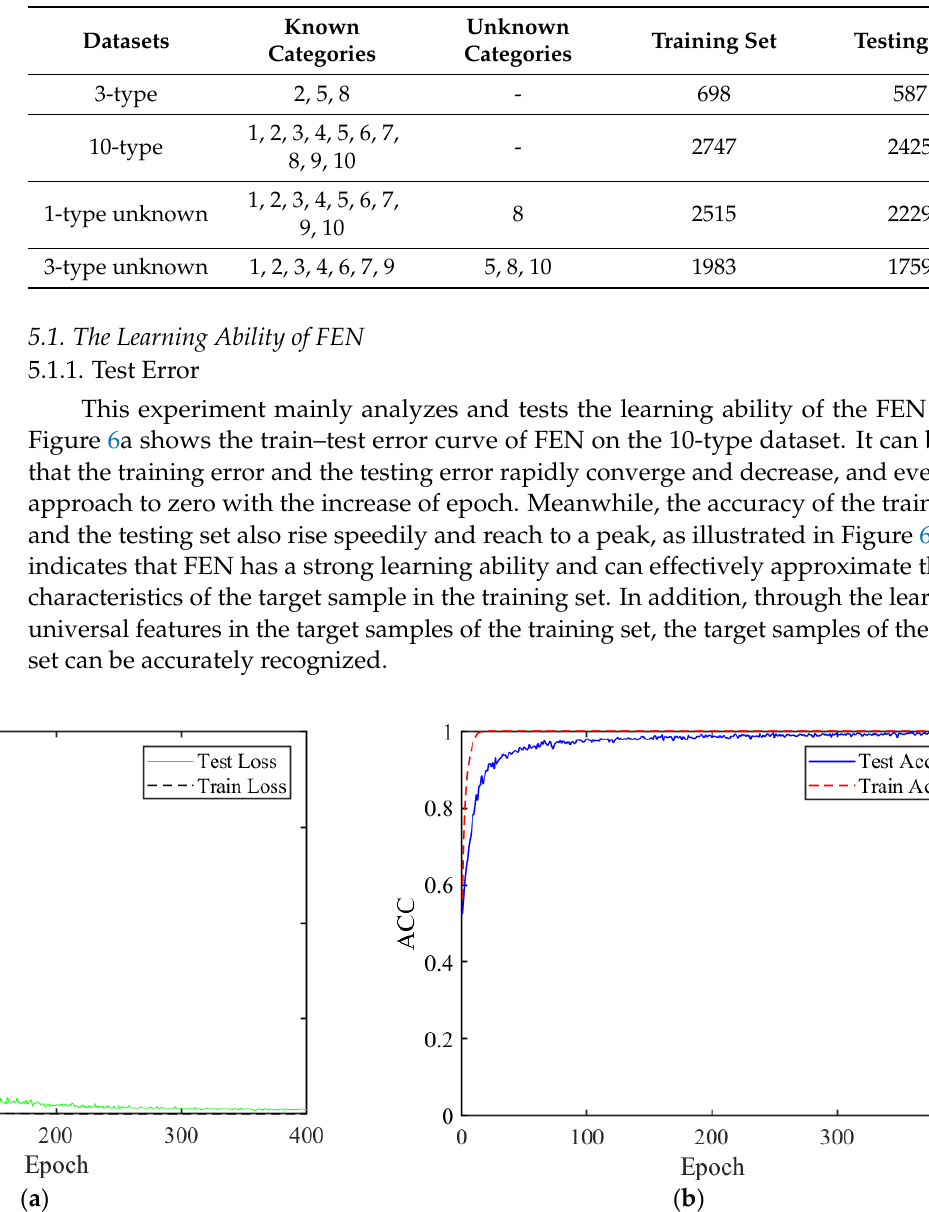
Table 3. Experimental datasets configuration.